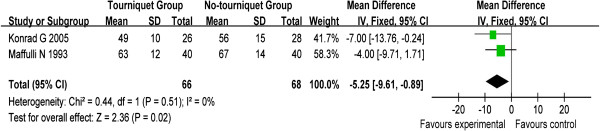
Meta-analysis of joint range of motion in the tourniquet and non-tourniquet groups.